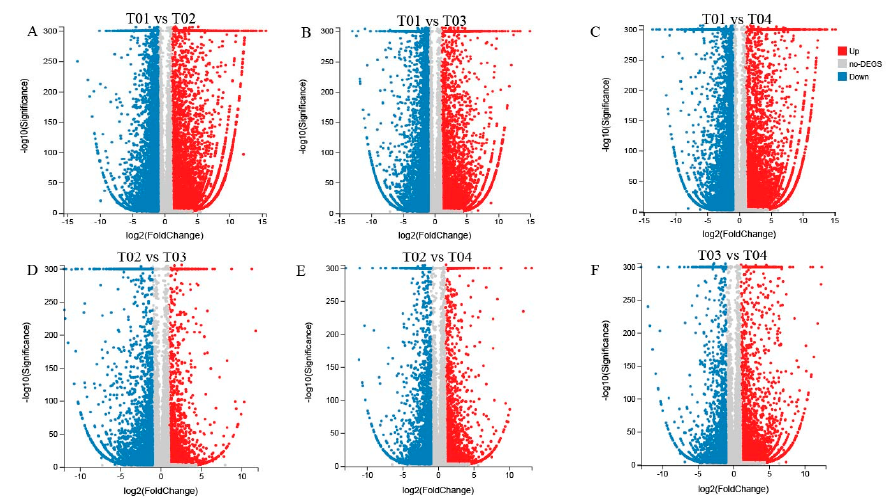
Figure 4. The numbers of up- and down-regulated genes among the four different stages.